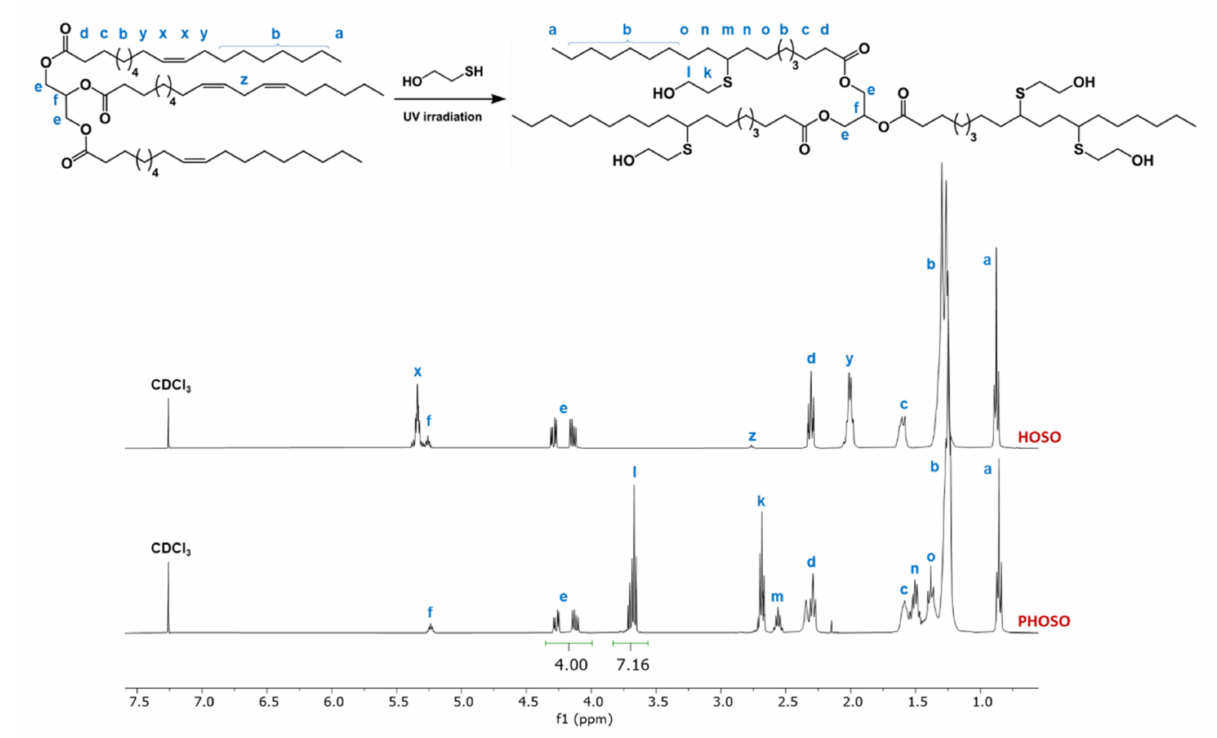
Figure 2. 1 H NMR spectra of HOSO and